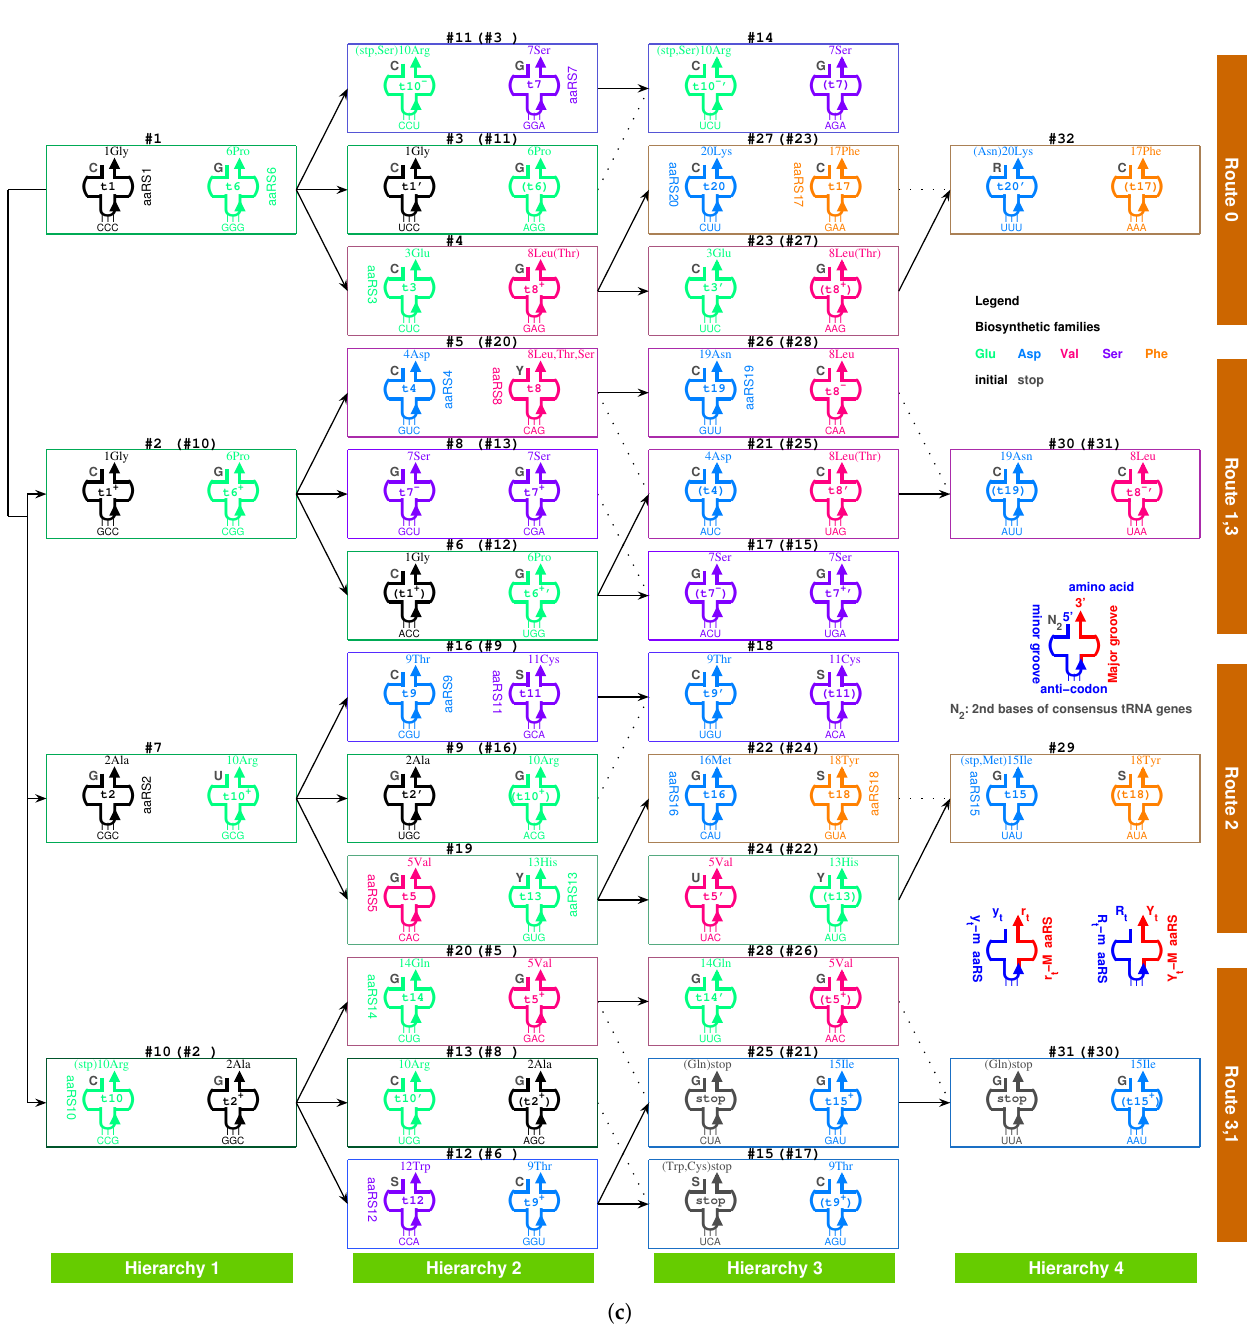
Figure 5. The origin and evolution of tRNAs along the roadmap. ( a ) The evolution of the 5 (cid:48) y t r t 3 (cid:48) type tRNAs by the triplex base pairings yr ∗ y t and yr ∗ r t . ( b ) The evolution of the 5 (cid:48) R t Y t 3 (cid:48) type tRNAs by the triplex base pairings yr ∗ R , yr ∗ Y and YR ∗ Y t and YR ∗ R t . The node numbers # n on the roadmap may exchange within or between routes because the sequences of Y and R are reverse to the sequences of y and r , respectively. ( c ) The coevolution of tRNAs with aaRSs along the roadmap, which determines the pair connections and route dualities. The aaRSs aaRS 1 to aaRS 20 combine, respectively, with the tRNAs t 1 to t 20 from certain major/minor groove side. The complementary relationship between the pyrimidine y t strand of the 5 (cid:48) y t r t 3 (cid:48) type tRNAs and the purine R t strand of the 5 (cid:48) R t Y t 3 (cid:48) type tRNAs agrees with the complementary relationship between G and C for the second bases of the consensus genes of tRNAs, especially for the early tRNAs in Route 0 and in Hierarchy